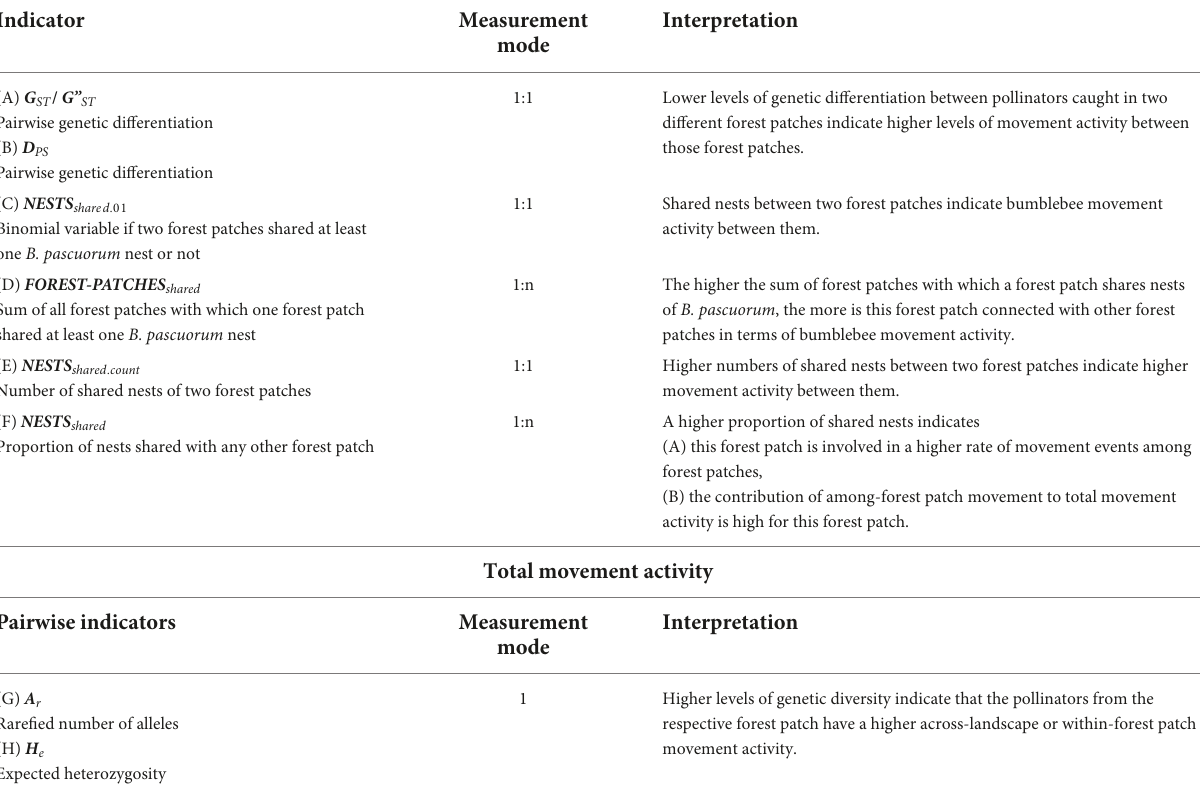
TABLE 2 Indicators of pollinator movement activity that indicate the among-forest patch and the total movement